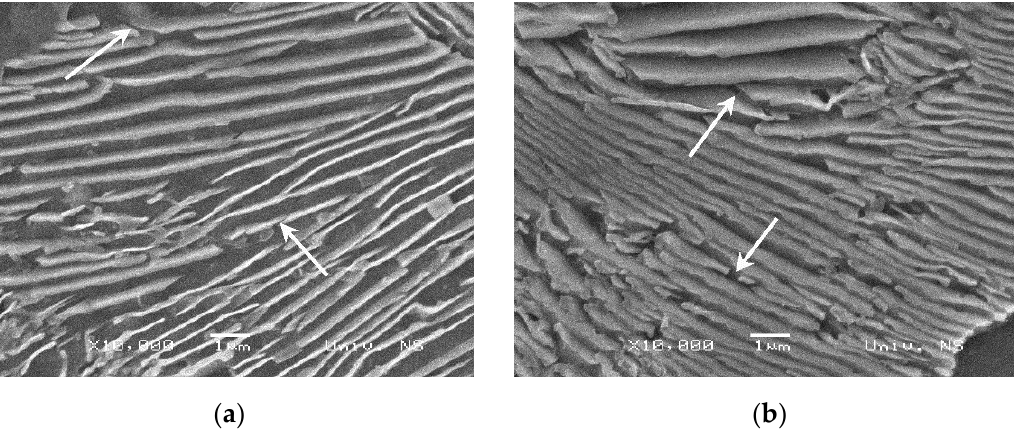
Figure 6. The SEM images of some fractured cementite lamellae of undeformed specimen: ( a ) Zone I; ( b ) Zone IV; (×10 000 magnification).